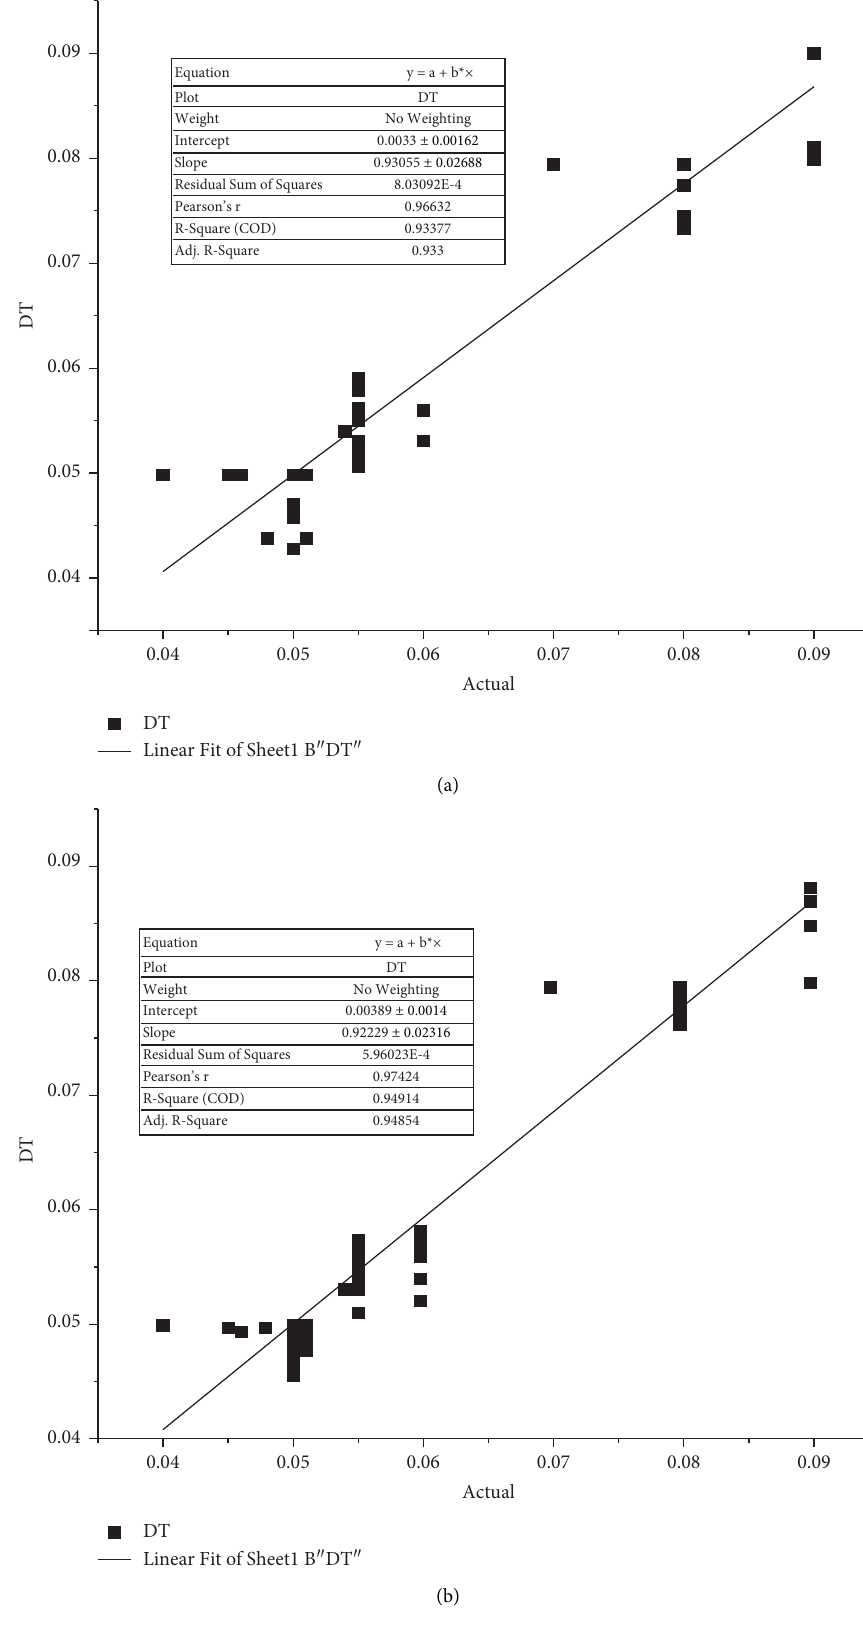
Figure 4: Te decision tree model scatter plots for the testing phase of the oil fow: (a) fracture porosity in oil system and (b) shape